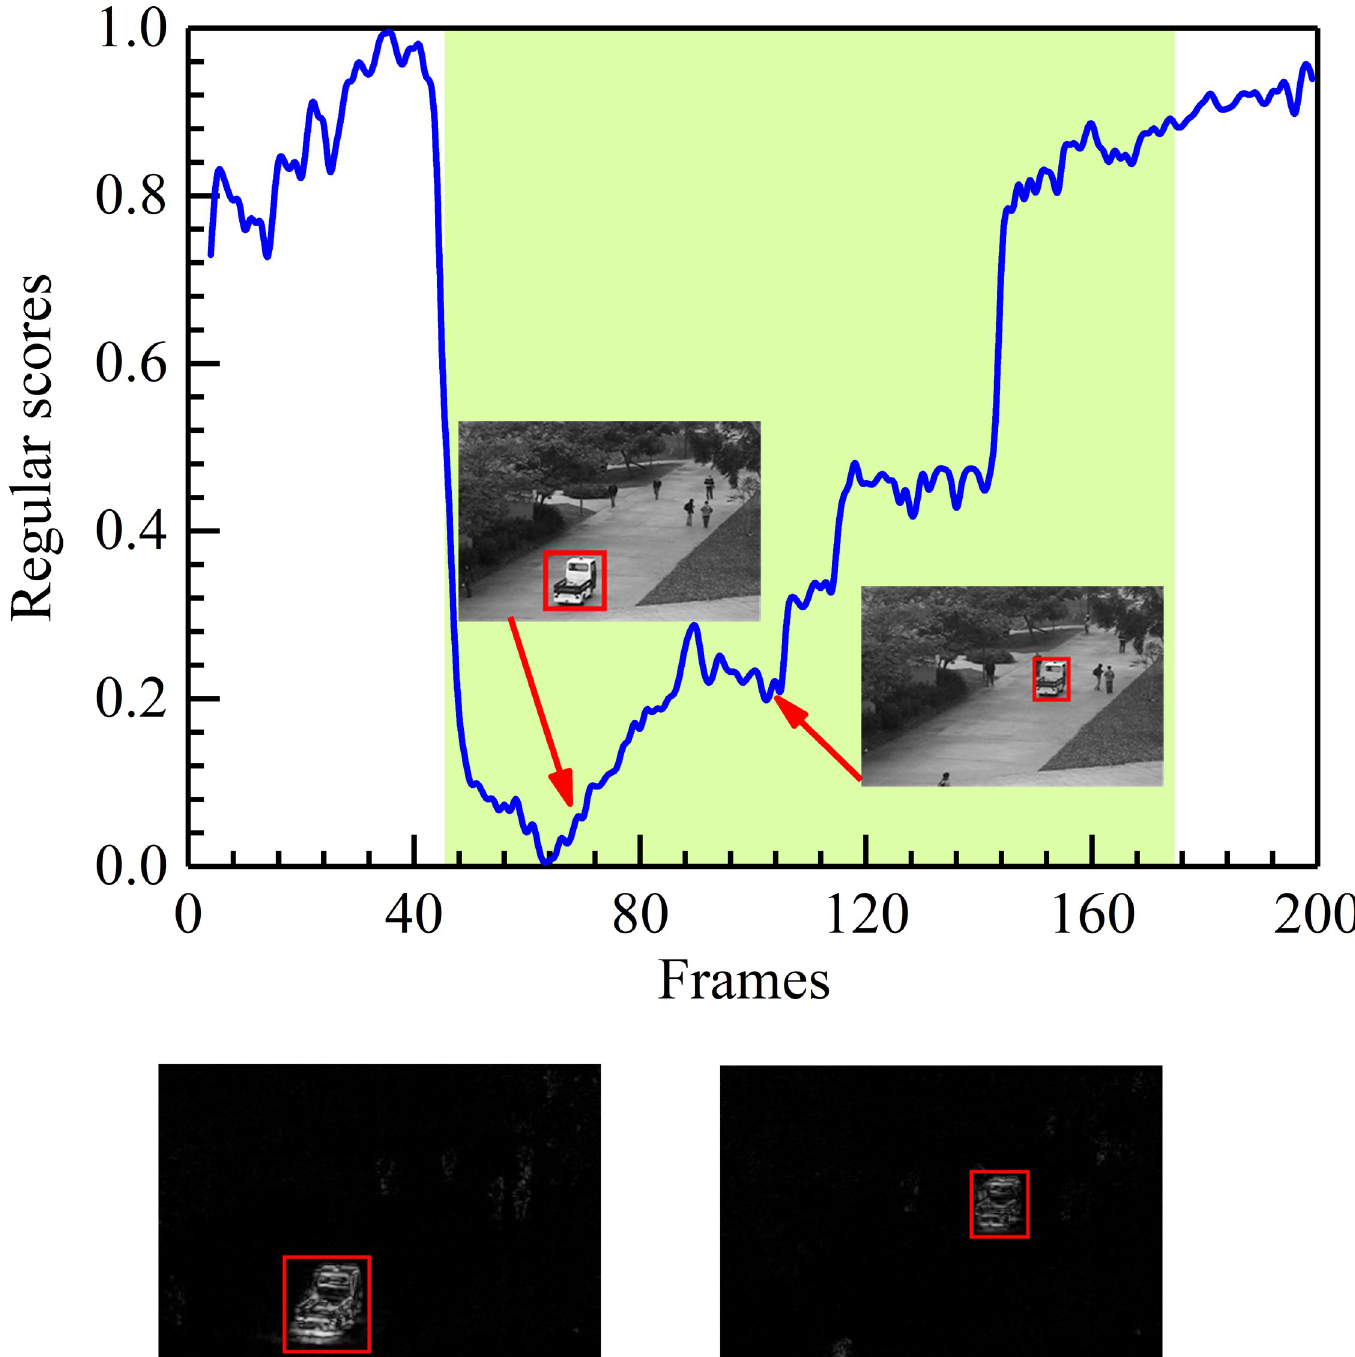
Fig 8. Frame-level evaluation results on the 20th test video of UCSD Ped1. (a) Relationship between the test video frames and the regular score. (b) Difference between the ground truth and the corresponding generated frame. regular scores matching the green area are anomalous events (e.g., throwing the bag). Fig 7B presents the difference (labeled with a red rectangle) between the ground truth and the corre- sponding generated frames. When running the proposed algorithm, the model has learned